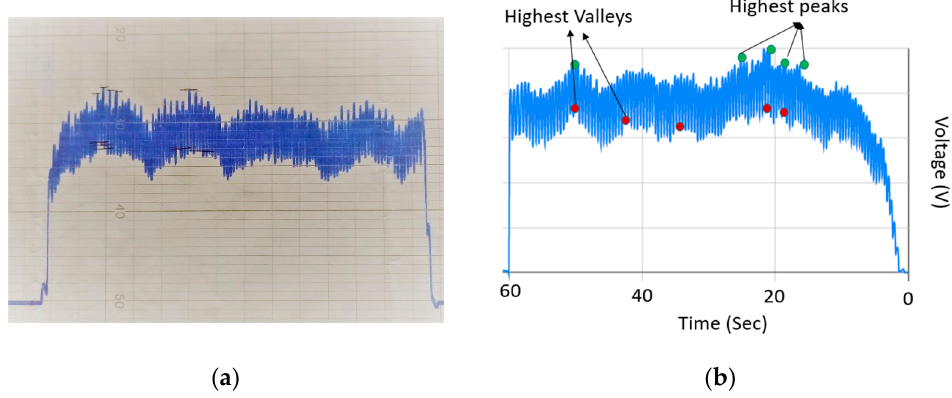
Figure 7. Electrostatic characterization graphs ( a ) plotted with standard plotter and manually highlight the five highest peaks and valleys, ( b ) plotted with the new plotter that automatically calculates the five highest peaks and valleys for Human Walking Mode.